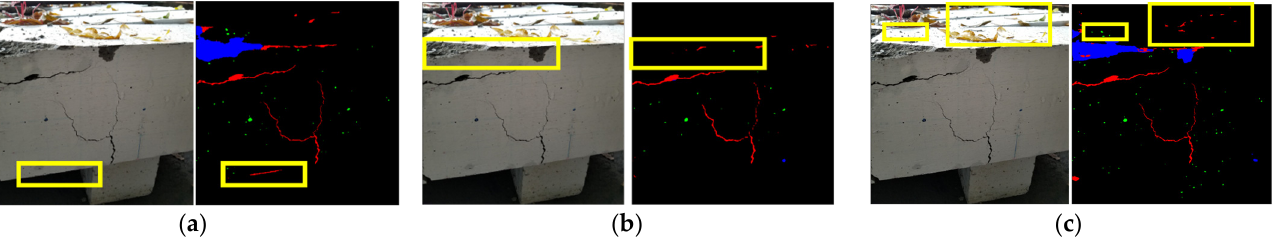
Figure 22. ( a ) Black edges detected as cracks on U-Net without regularization; ( b ) spalling not detected on DeepLabV3+ without regularization; ( c ) small rocks and leaves detected as damages on U-Net.